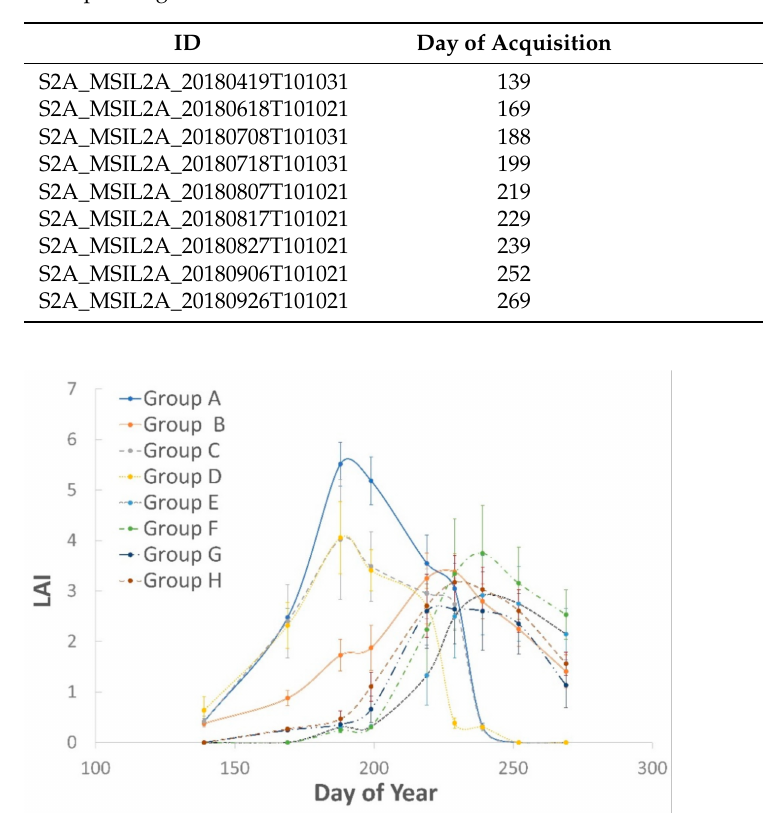
Figure 5. Average LAI Trend estimated from Sentinel-2 data. The error bars represent the standard deviation for each group of